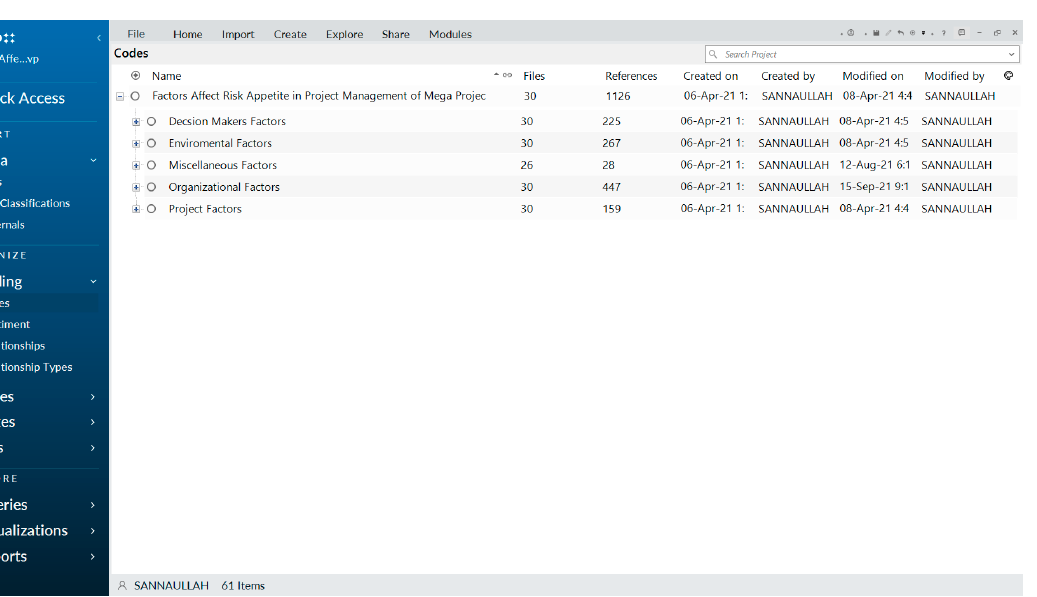
Figure 6. NVIVO codes.